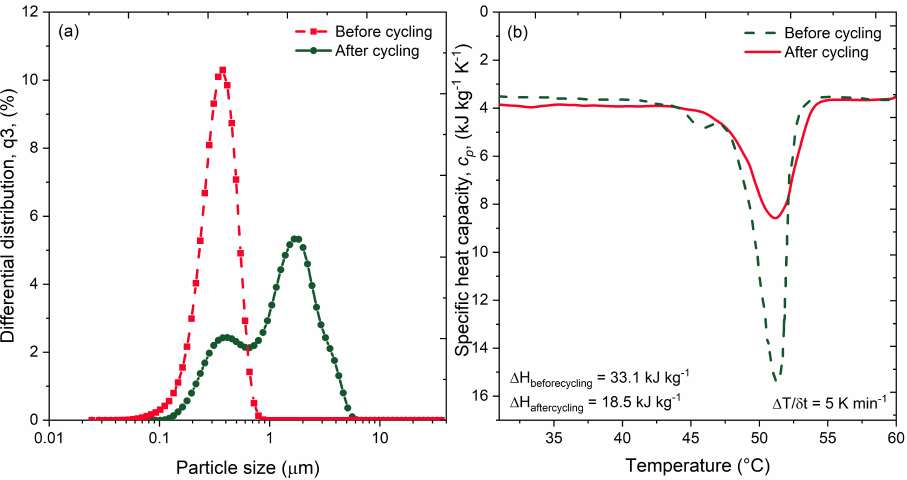
Figure 2. ( a ) Particle size distributions for the PCD used in this investigation before it was thermo-mechanically cycled and after it was cycled. ( b ) DSC analysis before and after the PCD was thermo-mechanically cycled for several weeks.